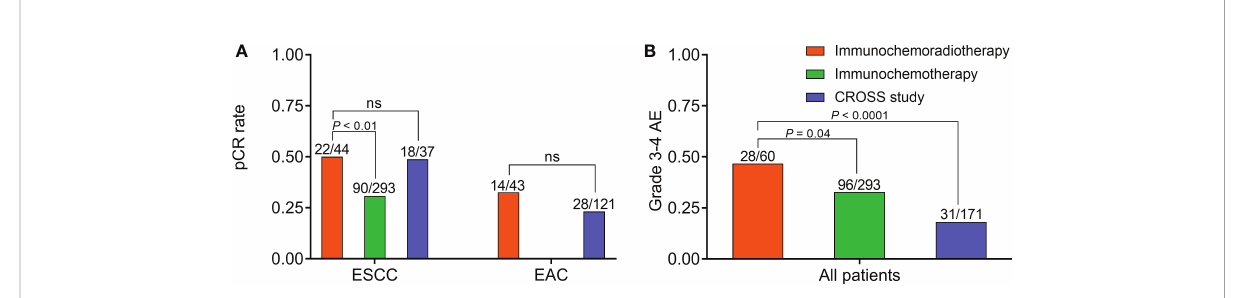
FIGURE 2 Ef fi cacy and safety of neoadjuvant immunochemoradiotherapy, neoadjuvant immunochemotherapy, and CROSS study. (A) Comparison of pCR rate in ESCC and EAC, respectively. (B) Comparison of grade 3-4 AE rate in all patients. AE, adverse effect; EAC, adenocarcinoma; ESCC, esophageal squamous cell carcinoma; NS, not signi fi cant; pCR, pathologically complete